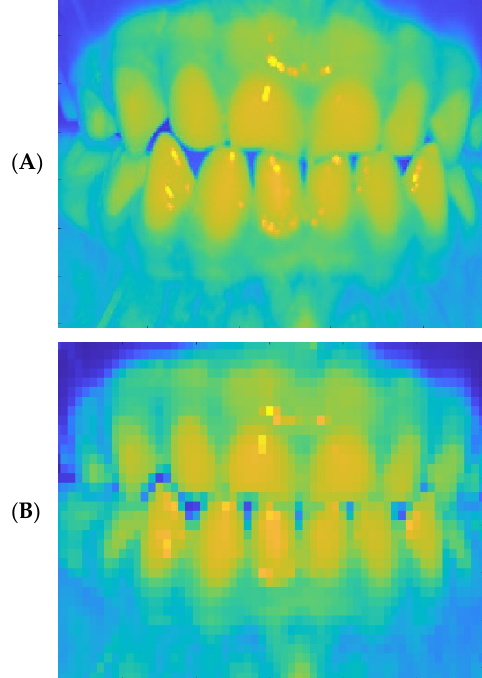
Figure 6. Obtaining the 2D k-symbol FHF transform to level 2. ( A ) Input image, ( B ) view of the k-symbol FHF approximation.